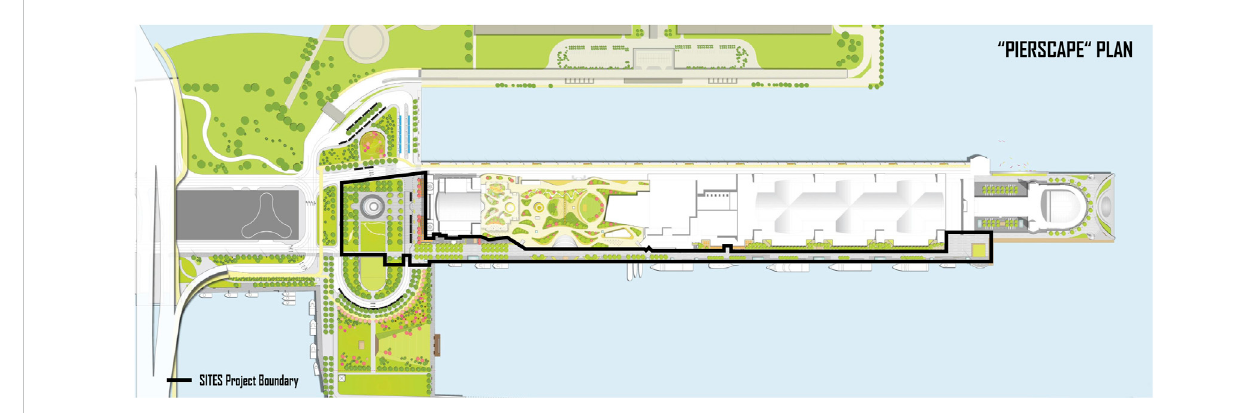
FIGURE 1 Site boundary of Chicago ’ s Navy Pier redevelopment project (James Corner Field Operations,